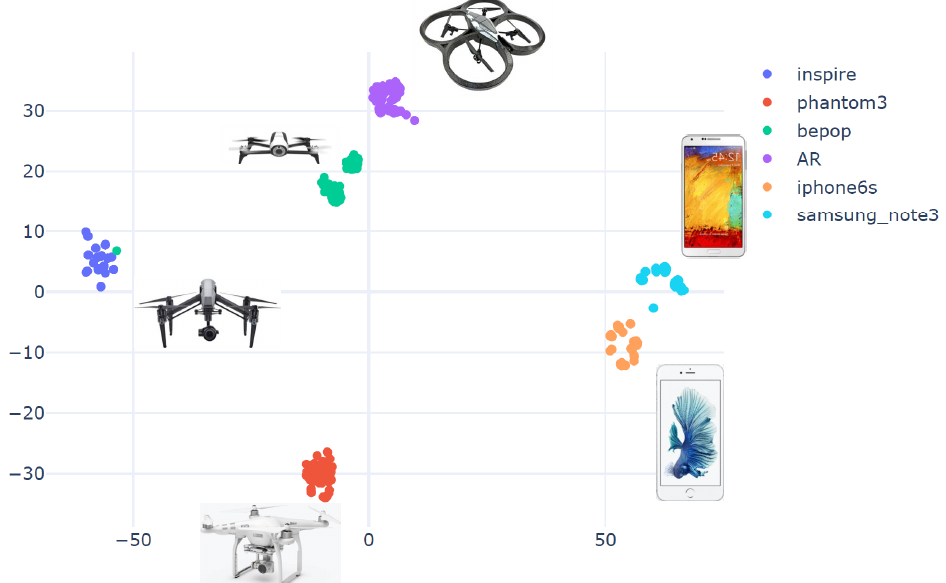
Figure 8. Cluster results for WST using